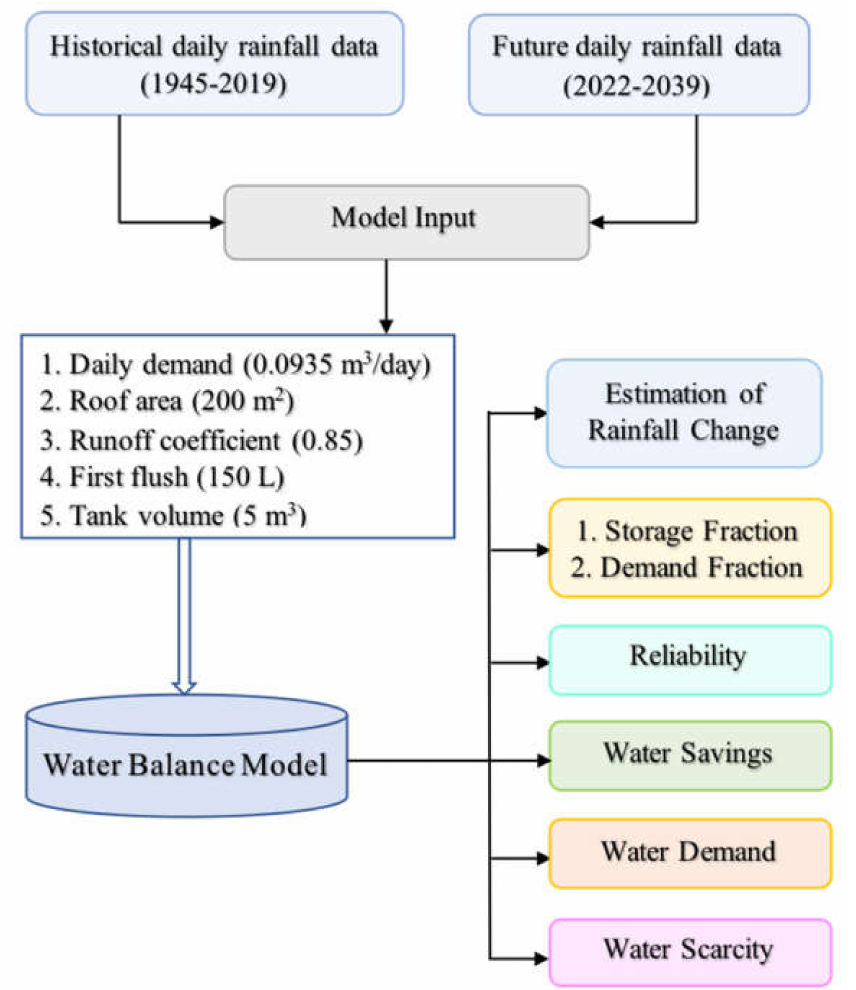
Figure 2. Flowchart showing the adopted methodology to evaluate the performance of a RWH